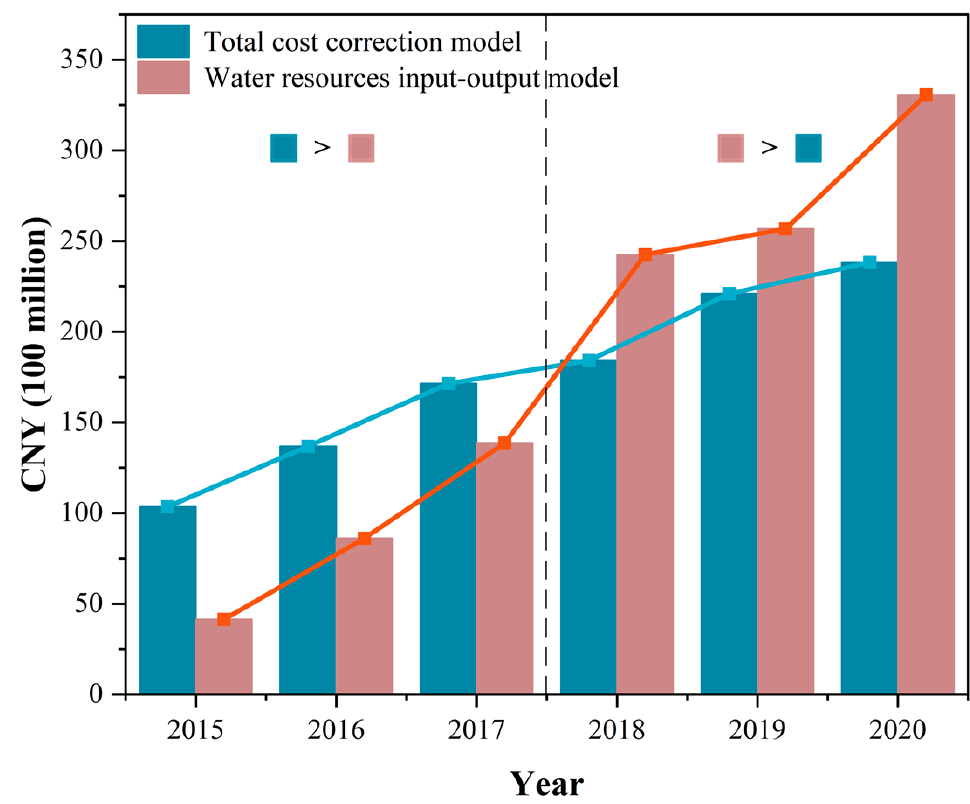
Figure 8. Comparison of the results of the total cost correction model and water resources input ‒ output model.